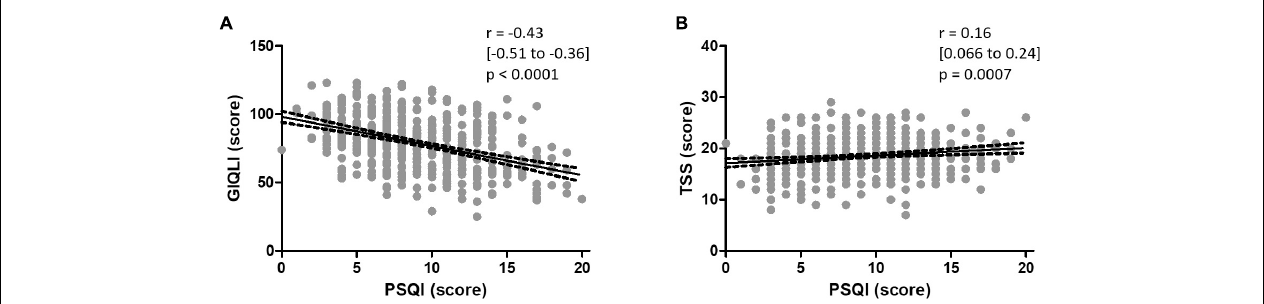
Normal sleep quality ( n = 66)